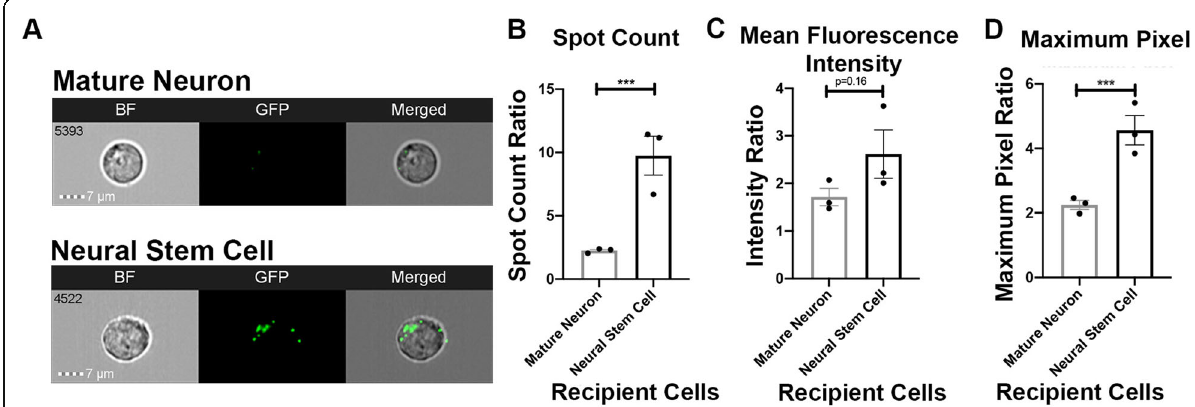
Fig. 6 Neural differentiation status affects HEK293T EV uptake. HEK293T EVs were co-cultured with mature human neurons and human neural stem cells. a Representative IFC images of recipient cells co-cultured with HEK293T EVs. b – d Quantification of EV uptake preference assays compared with controls and each other via spot count, mean fluorescence intensity, and maximum pixel ratios. Bars represent mean ± SEM; N = 3; unpaired T test. * p < 0.05; *** p < 0.01 compared with 0 EVs